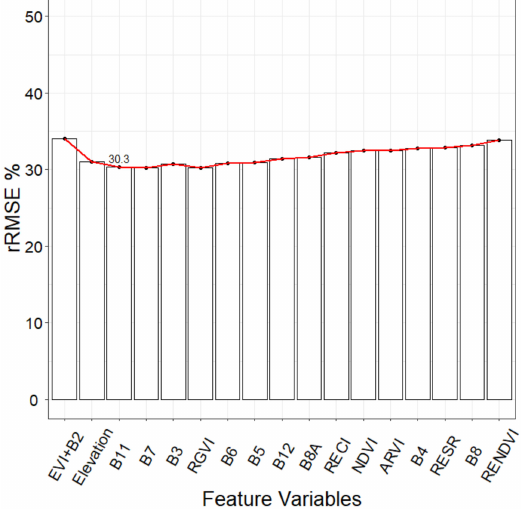
Figure 6. The SRF method applied to spectral variables for GSV